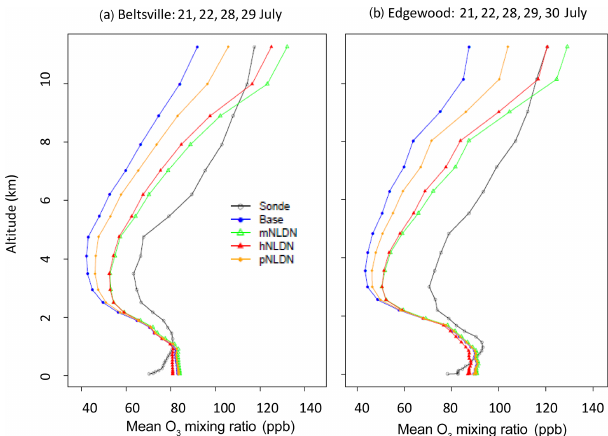
Figure 6. Vertical profiles of O 3 mixing ratios from ozonesonde measurements and model simulations at Beltsville, MD (a) ; and Edgewood, MD, (b) on the days when lightning NO produced sig- nificant impact on O 3 during the DISCOVER-AQ field study in July